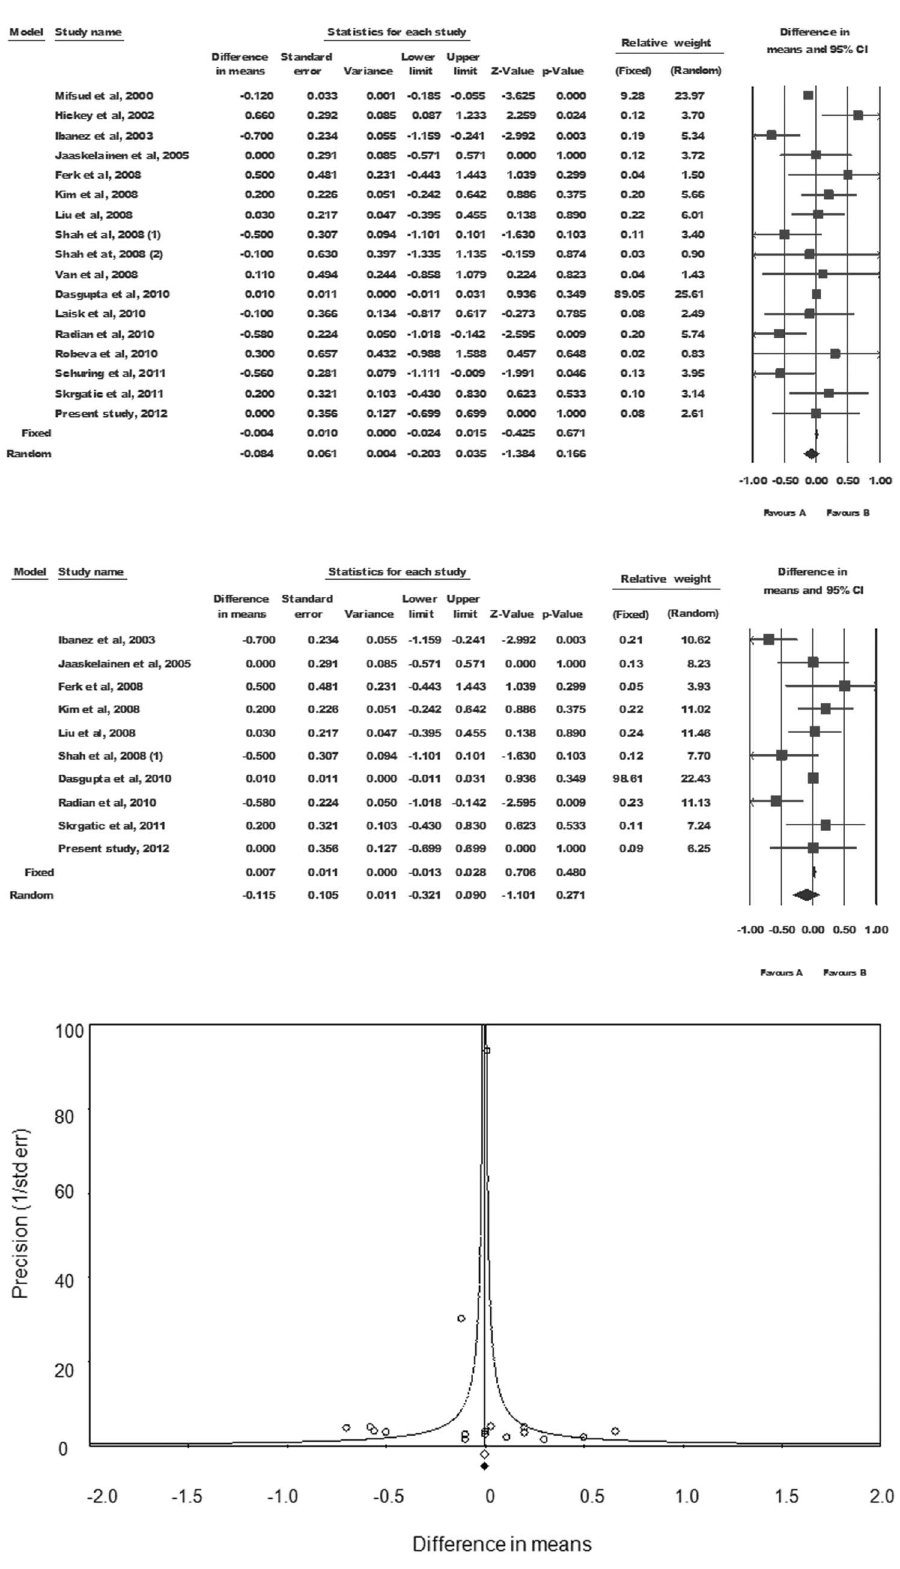
Figure 6. Meta-analysis. Forest plot for pooled data analysis (upper panel), forest plot after removal of studies using sample size less than 100 (middle panel), and funnel plot of precision by difference in means for publication bias (lower panel).